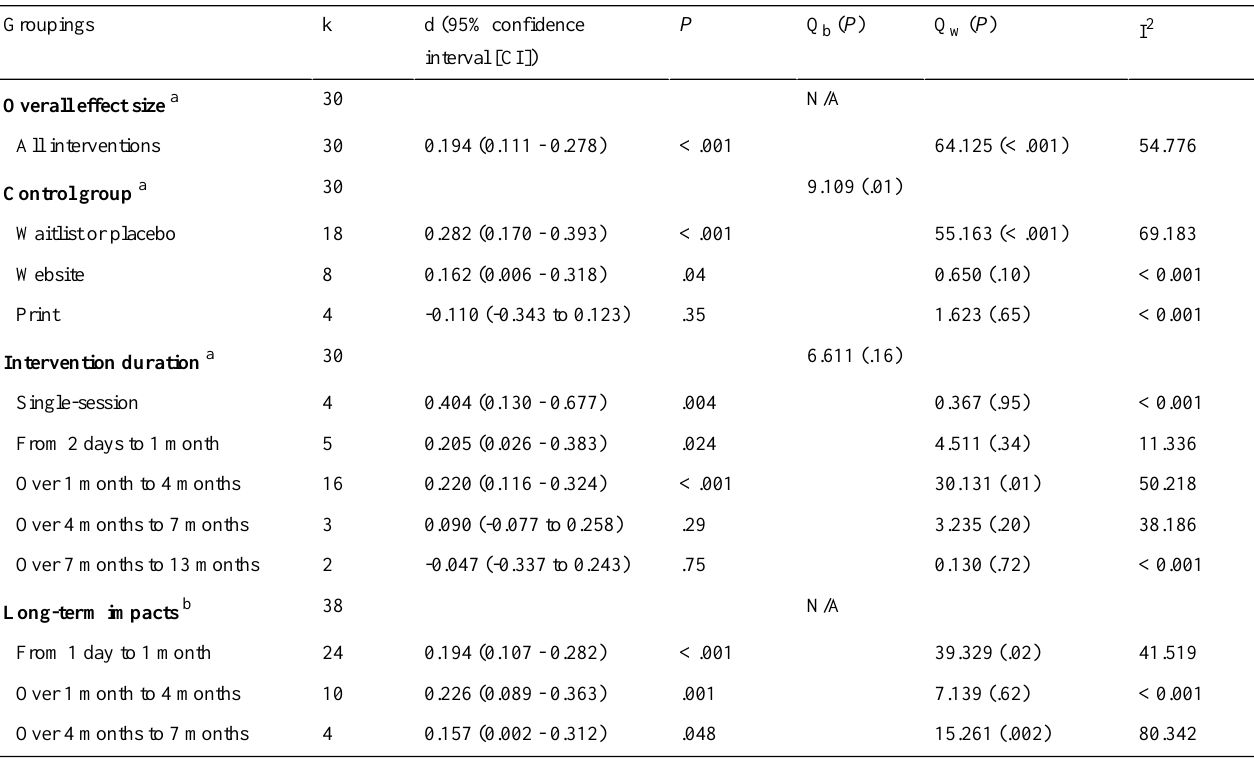
Table 4. Effect size